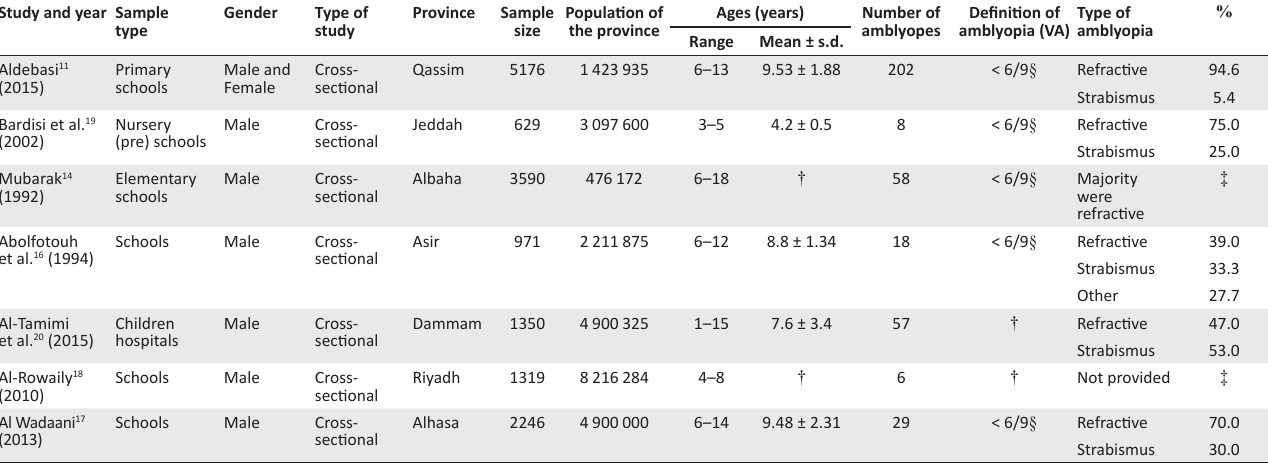
TABLE 2: Important characteristics of the seven studies included in this review.